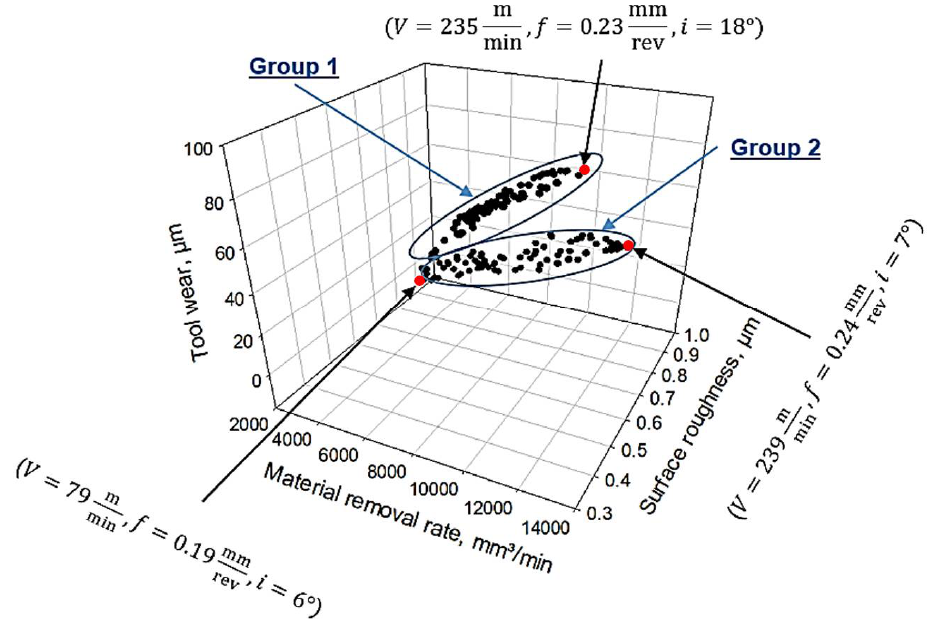
Figure 10. Pareto-front solutions.